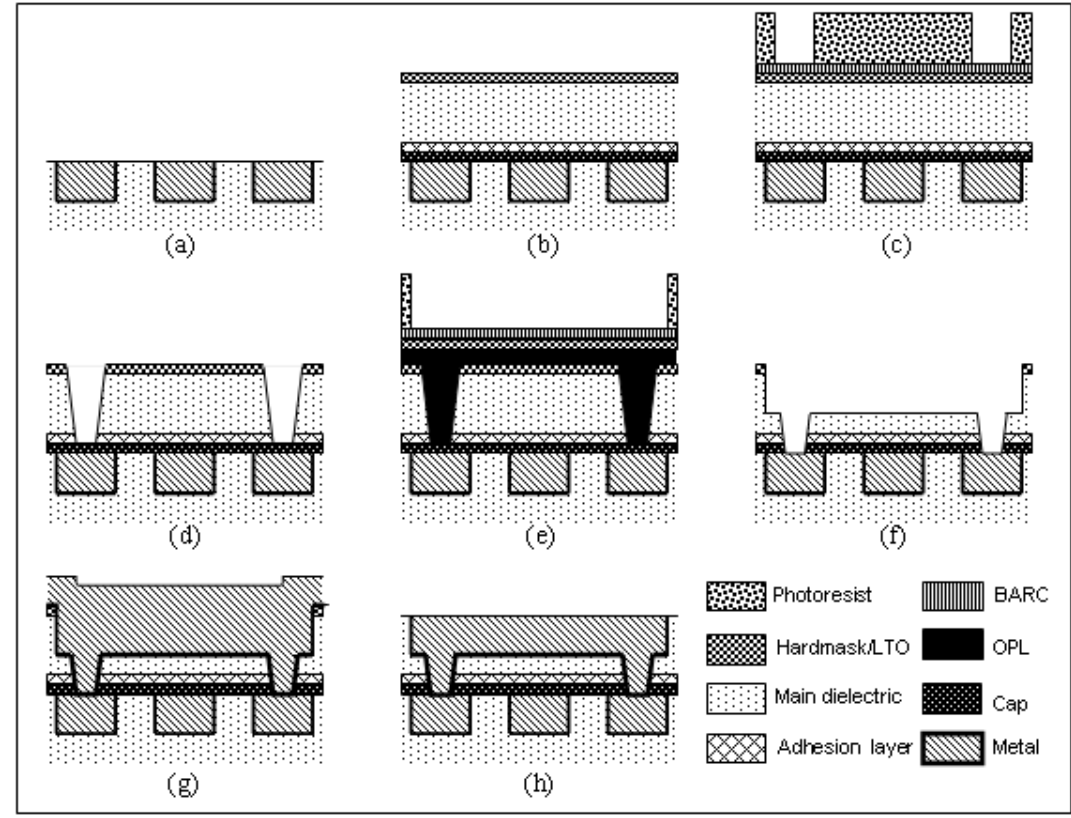
Figure 1. Schematic process flow for copper interconnects: (a) a planar array of wires embedded in a dielectric stack with top wire surfaces exposed; (b) deposition of a blanket dielectric stack; (c) photolithographic patterning of interlevel connections; (d) transfer of interlevel connection pattern into the dielectric stack; (e) photolithographic patterning of the intralevel wiring; (f) transfer of the intralevel wiring pattern into the dielectric stack; (g) metal deposition; (h) planarization of metal